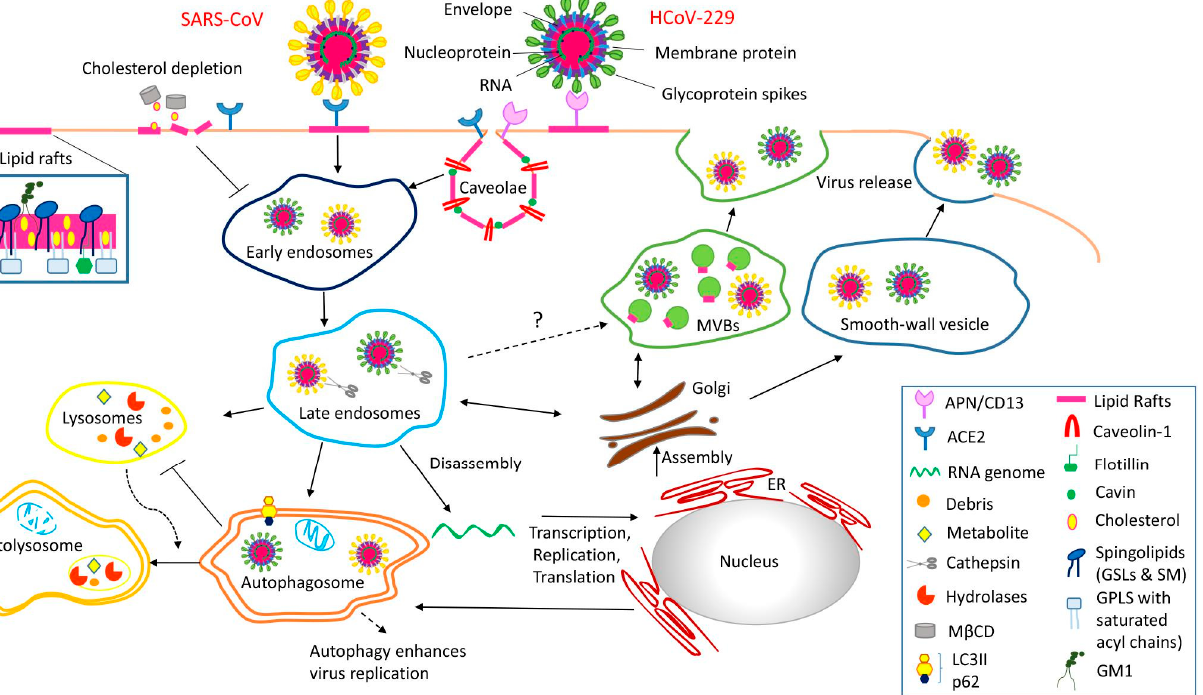
Figure 4. SARS-CoV-2 infection is tightly regulated spatiotemporally. A viral spike glycoprotein bound to the host receptor (ACE2, APN/CD13) of lipid rafts/caveolae for viral entry triggers the downstream mechanism of pathogenesis and immunity (adapted from [41]. Alternatively, viruses hijack autophagy machinery for viral replication. Third, we speculate that coronavirus might utilize multivesicular bodies (MVBs) and take advantage of the exosomal pathway for egress (adapted from [41]. Caveolae-budded EVs are potential hijackable gates in cell communication of caveolin- related diseases named caveolinopathies. Note that the question mark indicates an alternative pathway as speculated for coronavirus to utilize multivesicular bodies (MVBs) and to take advantage of the exosomal pathway for egress. [Figure reproduced under Creative Commons Attribution-NonCommercial License 4.0 (CC BY-912)].